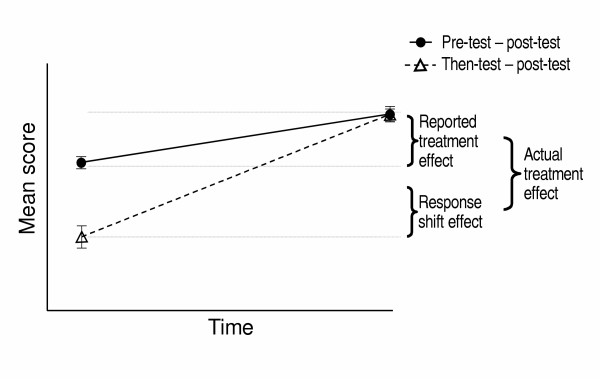
The then-test approach to measuring response shift (from Sprangers et al 1999) [27].